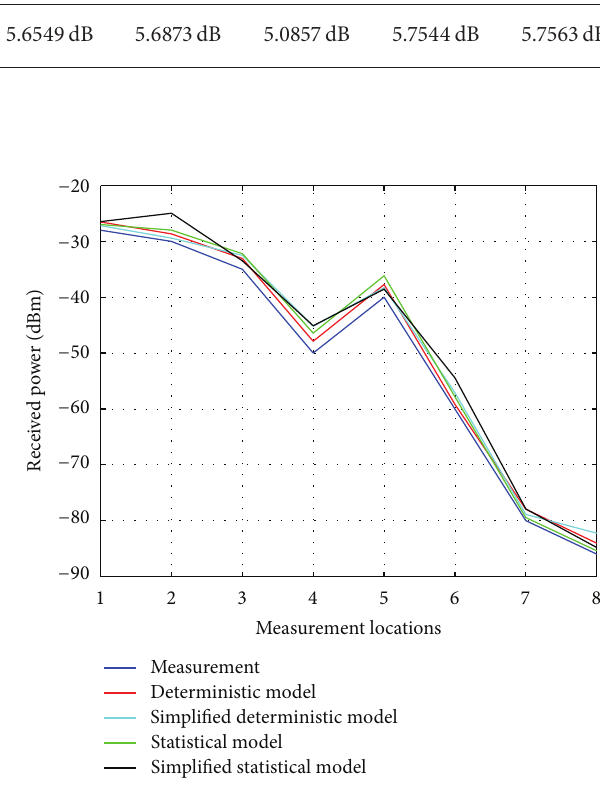
Figure 10: Average received power in downlink. Figure 11: Average received power in